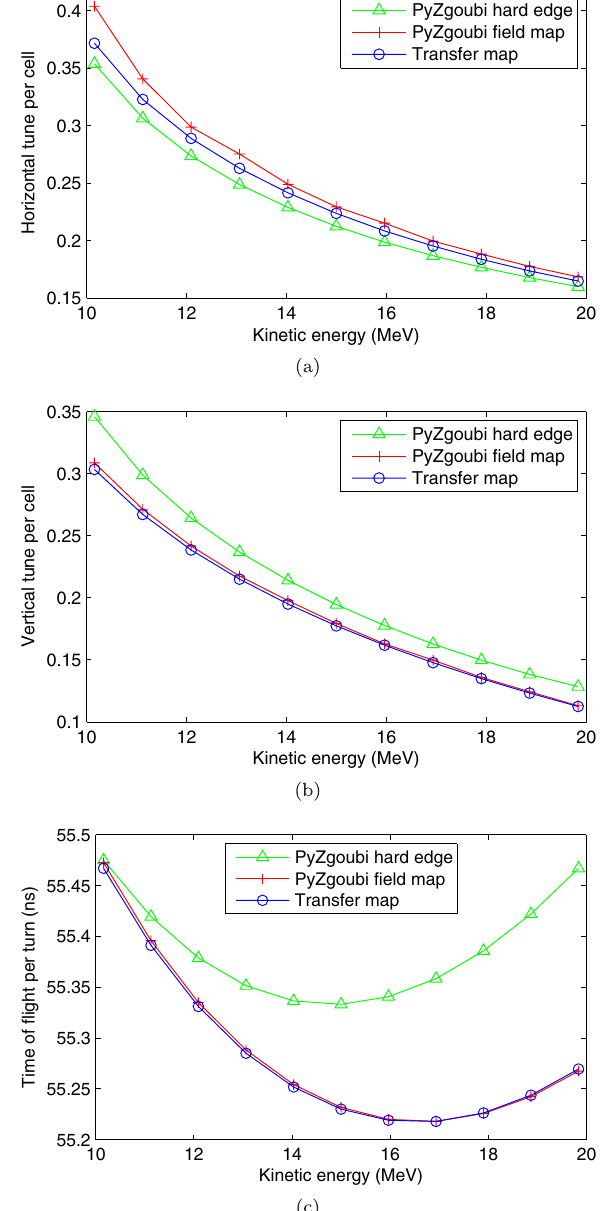
FIG. 6. (a) Horizontal tune, (b) vertical tune, and (c) time of flightversuskineticenergycomputedwithahard-edgemodel,and withfieldmaps.Weobserveamaximumdiscrepancyofabout0.05 at 10 MeV for the horizontal tune per cell, between the transfer map and numerical tracking with the fringe field, but generally the two techniques are in good agreement. However, there are sig- nificant differences over the full energy range between the hard- edge model and the detailed fringe field (field map) model. With fringe fields, the minimum time of flight is reduced by 200 ps, and the energy at which this occurs is shifted from 15 to 17 MeV.